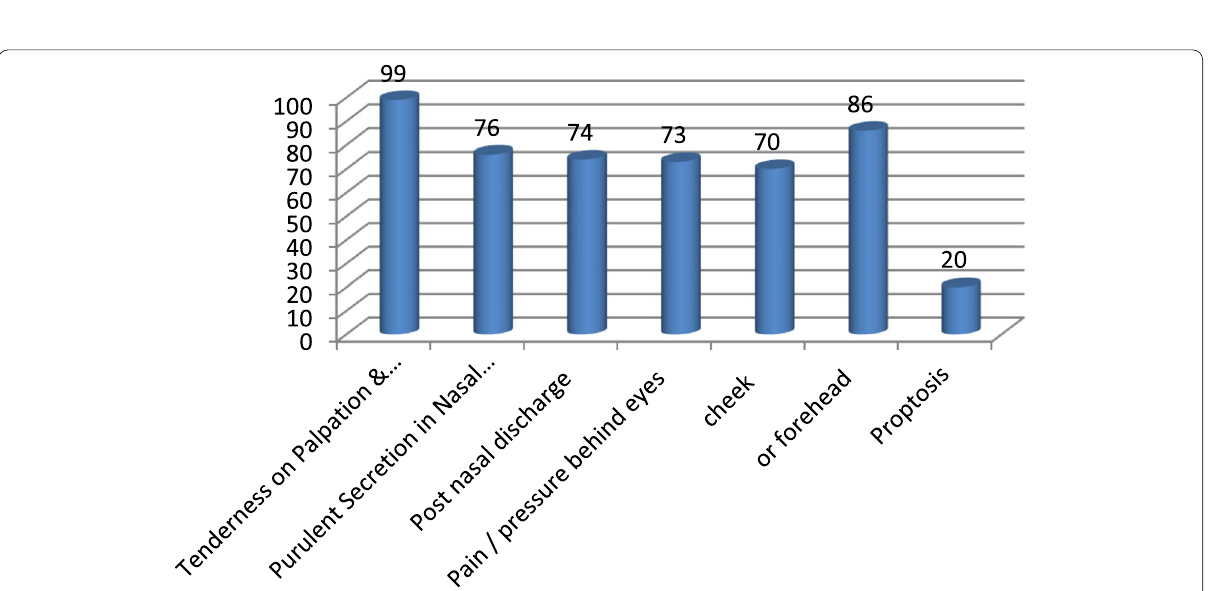
Fig. 2 Distribution of signs of patients with acute